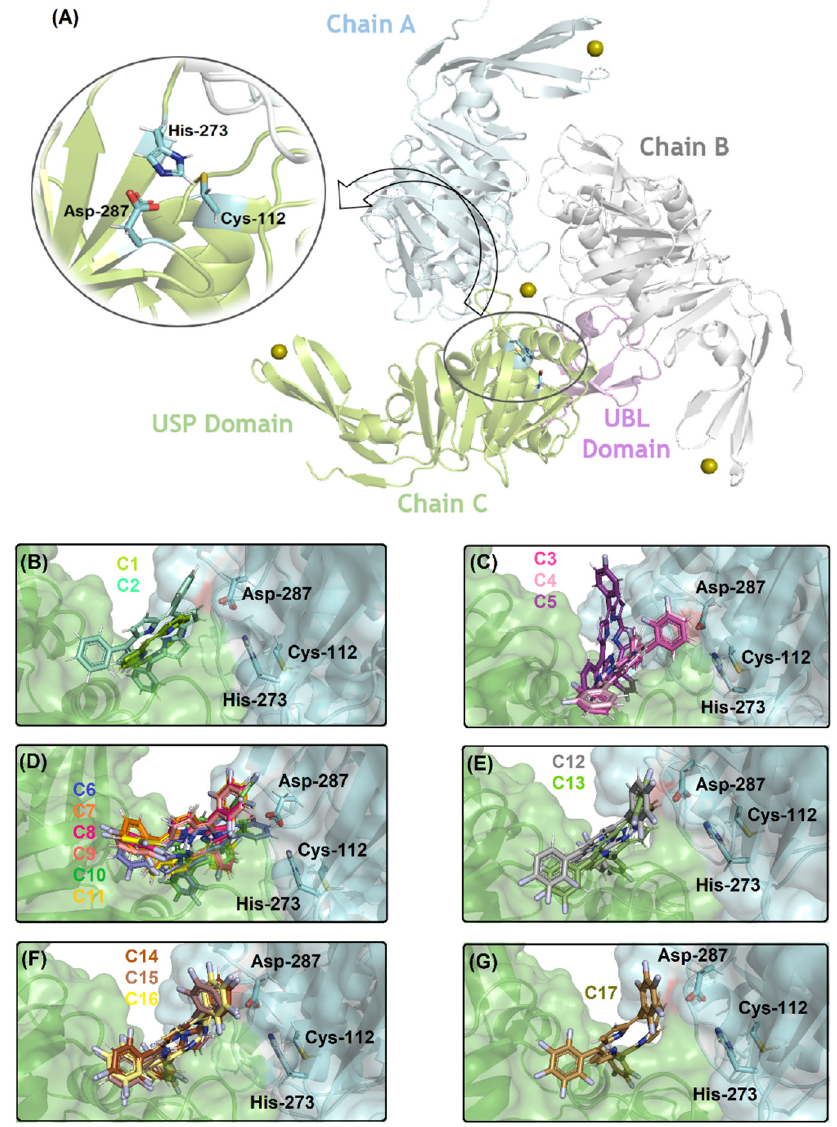
Figure 4. ( A ) The 3D structure for PL pro (PDB code: 6W9C) highlighting the catalytic Cys-His-Asp triad (as stick in cyan). Superposition of the best docking pose for the interaction between PL pro (as surface) with ( B ) non-fluorinated-corroles ( C1 , C2 ), ( C ) mono-fluorinated-corroles ( C3 – C5 ), ( D ) di-fluorinated-corroles ( C6 – C11 ), ( E ) tri-fluorinated-corroles ( C12 , C13 ), ( F ) tetra-fluorinated-corroles ( C14 – C16 ), and ( G ) penta-fluorinated-corroles ( C17 ) into the catalytic triad pocket. The PL pro structure is in cartoon representation divided into chains A, B, and C in blue, light gray, and green, respectively. The N -terminal ubiquitin-like (UBL) and C -terminal ubiquitin-specific (USP) domains are in violet and green (the β -sheets which interact with Zn(II) ion) into chain C, respectively. The Zn(II) ions are in sphere representation in olive, and the corresponding carbon’s color of each corrole that was used in this study is in stick representation according to the 3D chemical structure of the Figure 1. The elements’ color: hydrogen, nitrogen, fluorine, and oxygen in white, dark blue, light blue, and red, respectively.